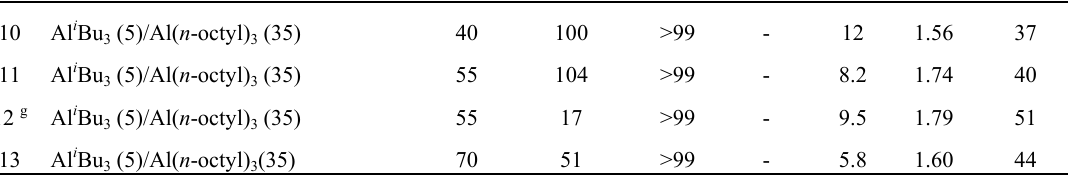
Figure 3. 13 C NMR spectra for the resultant polymers (acetone insoluble fraction) prepared by Cp*TiCl